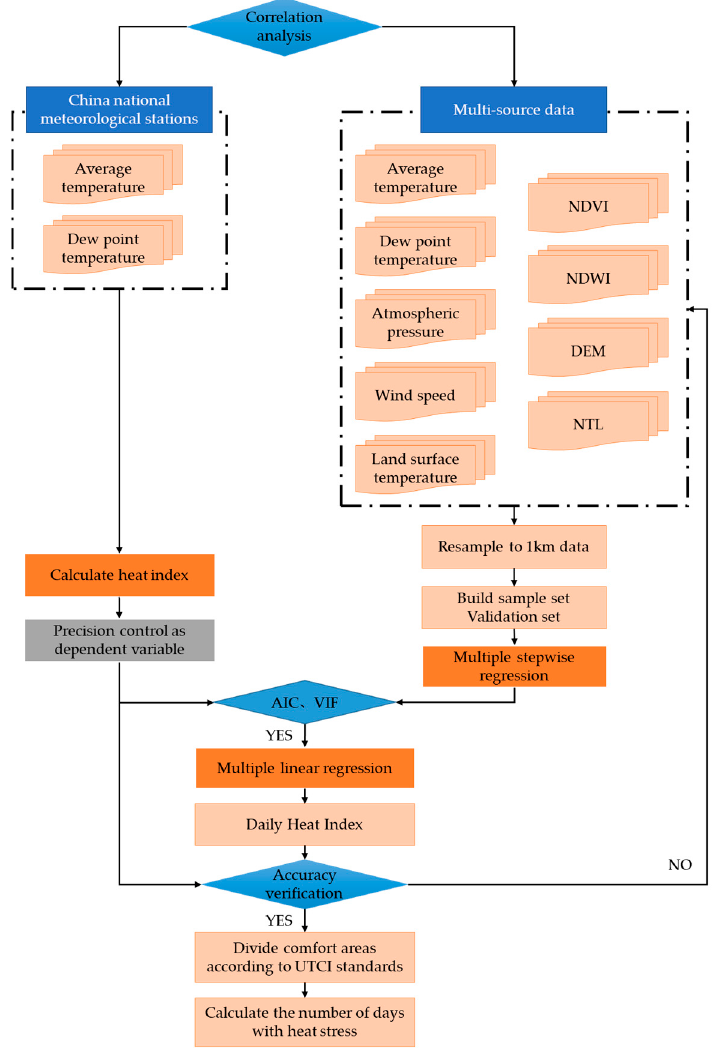
Figure 3. The technical method for calculating the distribution of thermal comfort areas and cumulative heat stress duration days in this study.